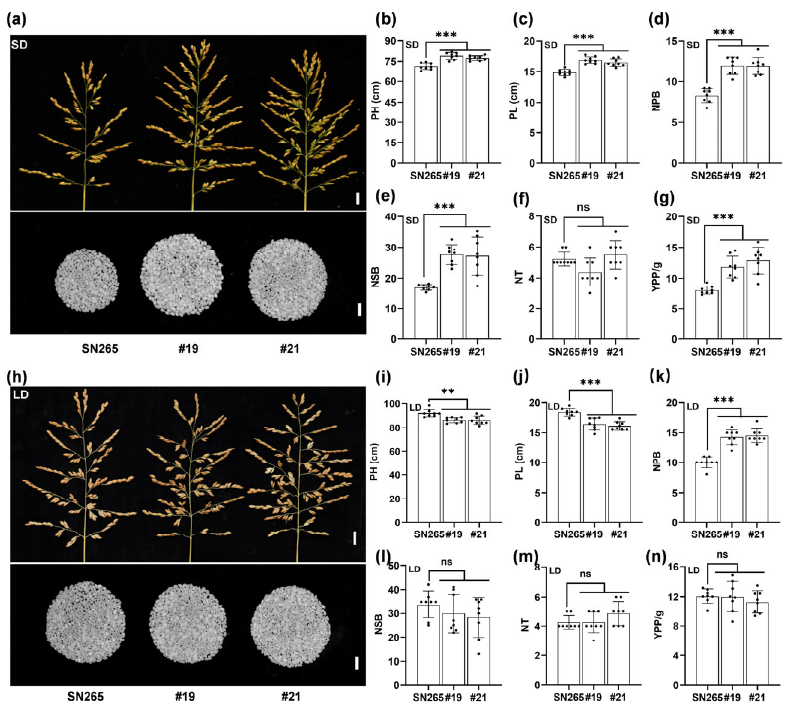
Figure 3. Double mutation of DTH2 and OsCO3 improves the agronomic performance of japonica rice under SD and LD conditions. ( a ) and ( h ) The panicle shape and number of polished grains of SN265 and dth2 - osco3 lines growing under SD and LD conditions. Scale bar for the panicles, 1 cm; scale bar for the polished grains, 10 mm. ( b ) and ( i ) the plant height, PH. ( c ) and ( j ) the panicle length, PL. ( d ) and ( k ) the number of primary branches, NPB. ( e ) and ( l ) the number of secondary branches, NSB. ( f ) and ( m ) the number of tillers, NT. ( g ) and ( n ) the yield per plant, YPP. YPP( g ) = (the number of spikelets per plant × seed setting rate × per 1000-grain weight)/1000. Values are means ± SD. **, p < 0.01. ***, p < 0.001. ns, no signi fi cance.